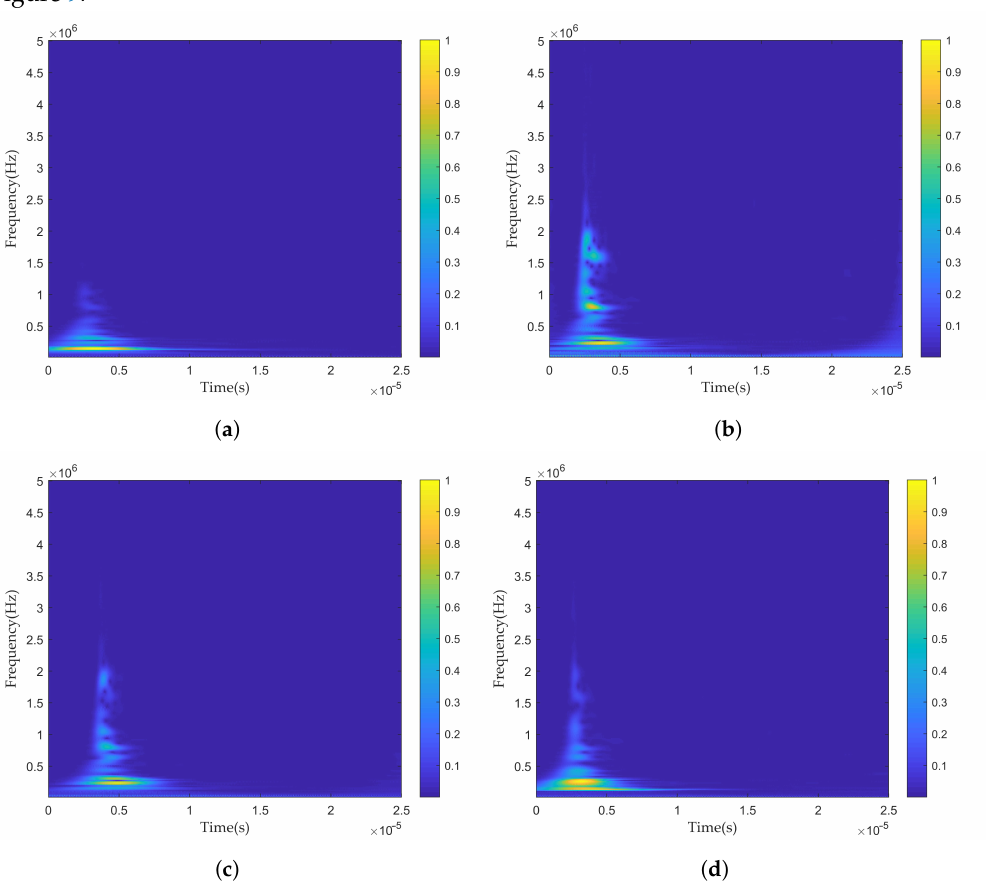
Figure 9. PD wavelet time-frequency diagrams: ( a ) point discharge; ( b ) surface discharge; ( c ) air gap discharge; ( d ) suspended